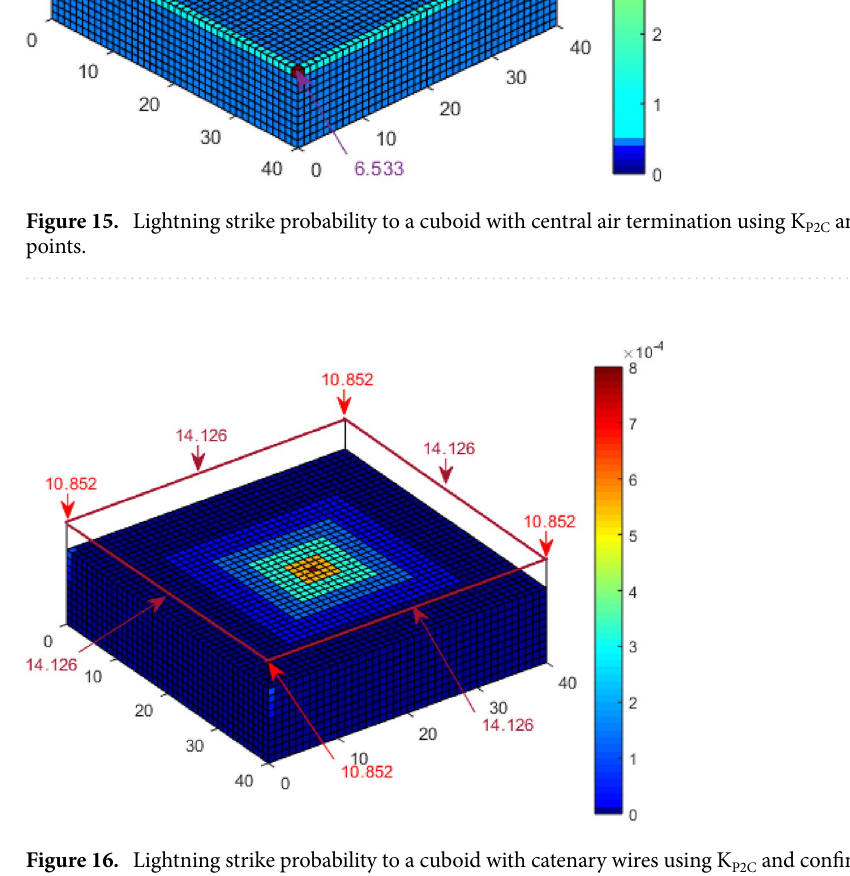
Figure 16. Lightning strike probability to a cuboid with catenary wires using K P2C and confined space